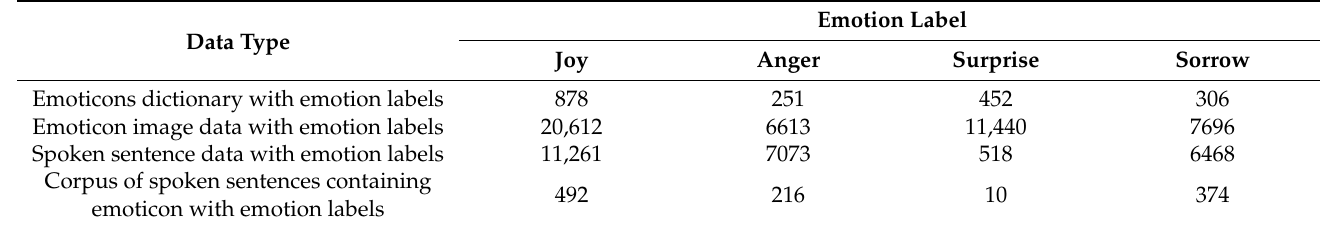
Table 3. Datasets used for training and evaluation (training:validation =